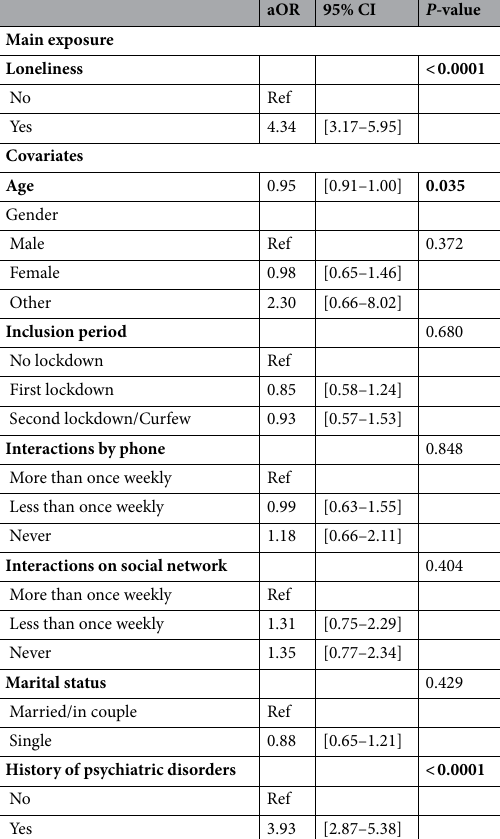
Table 2. Association between loneliness and suicidal thoughts. Binary logistic regression models. Adjusted on age, gender, inclusion period, interactions by phone, interactions on social network, marital status and history of psychiatric disorders. Significant values are in